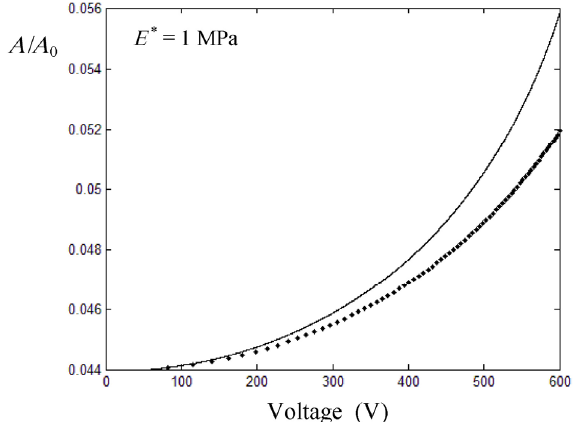
A A  as a function of the 0 applied voltage for the finger skin, with the effective Young’s modulus 1 MPa E   and 10 kPa p  . The roughness effects of 0 the SC layer are considered for the data shown by the solid curve, while the roughness effects are not included for the data shown by the dotted